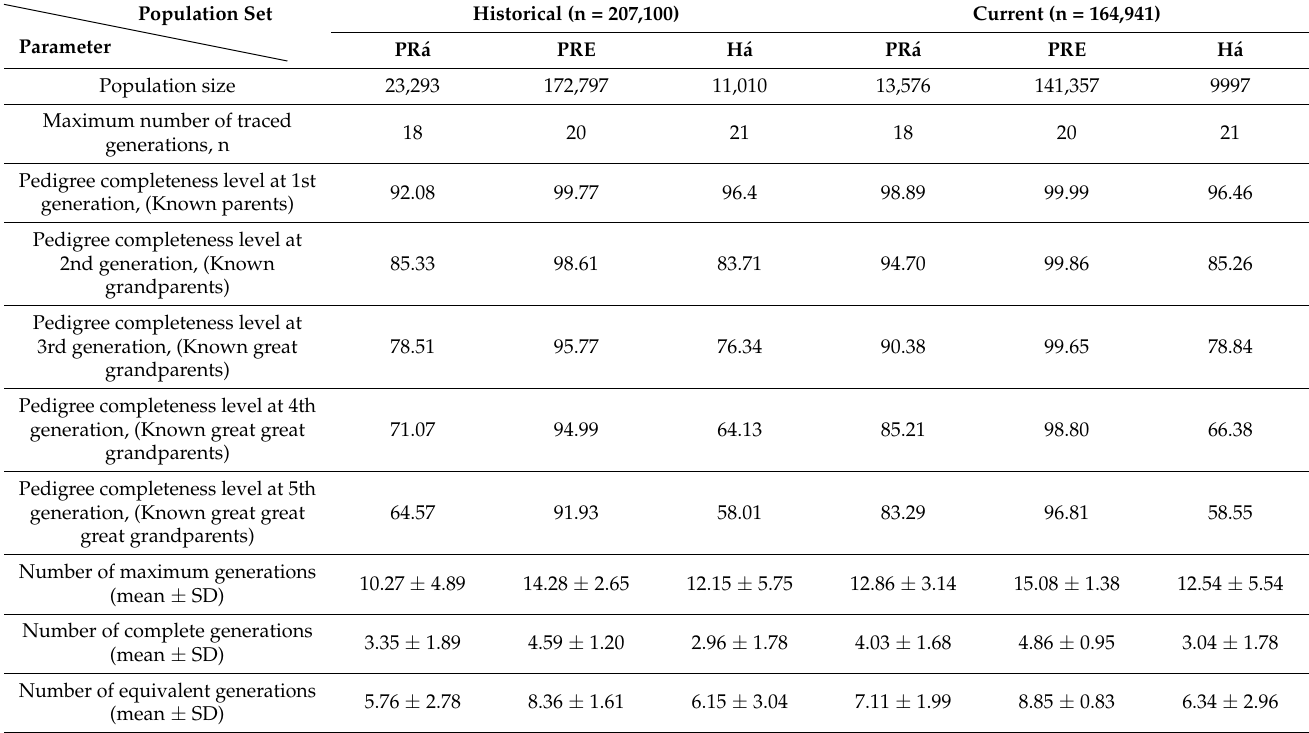
Table 1. Statistics summary of the analysis of the pedigree, maximum number of traced generations, pedigree completeness (1st, 2nd, 3rd, 4th and 5th generation), number of maximum generations, number of complete generations and number of equivalent generations in the studied population sets for Arabian Purebred (PR á ), Spanish Purebred (PRE) and Hispano- Arabian (H á ) horse